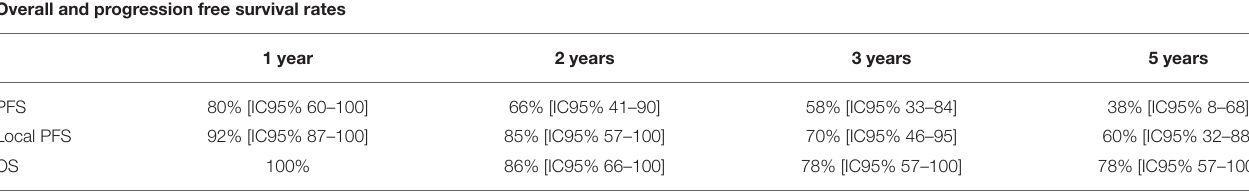
TABLE 2 | Overall and progression free survival rates at 1, 2, 3 and 5 years. Overall and progression free survival rates